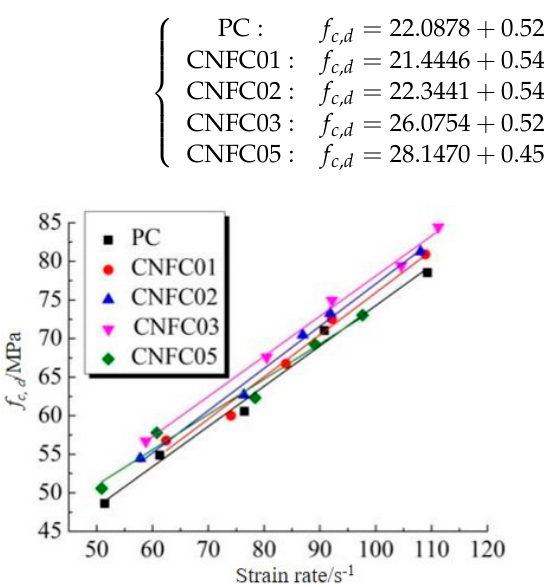
Figure 7. Dynamic compressive strength of concrete under different strain rates.